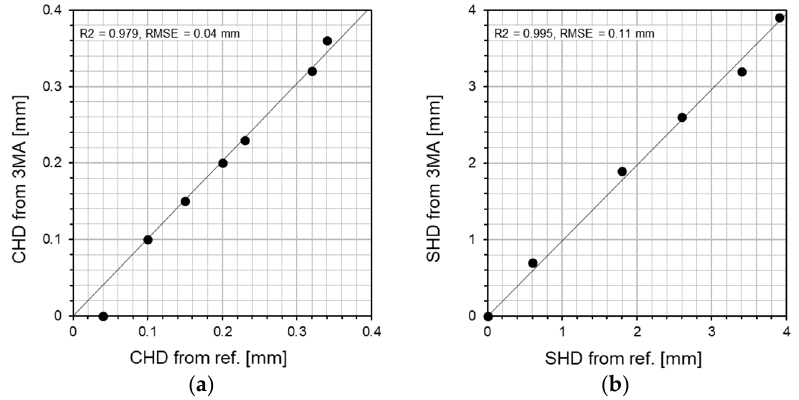
Figure 23. Results of the calibration to hardening depth: ( a ) case ‐ hardening depth (CHD) and ( b ) surface ‐ hardening depth (SHD).